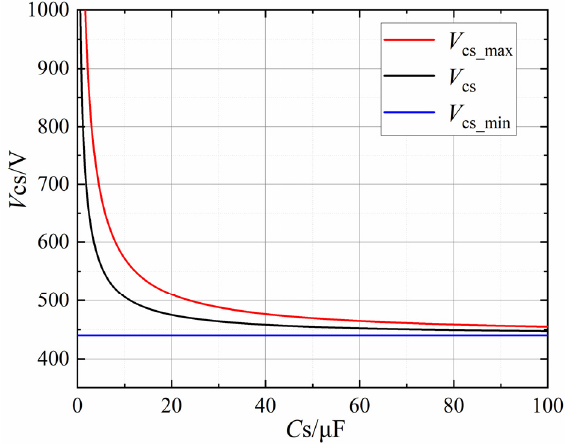
Figure 9. The relationship between voltage and capacitance of the decoupling capacitor.